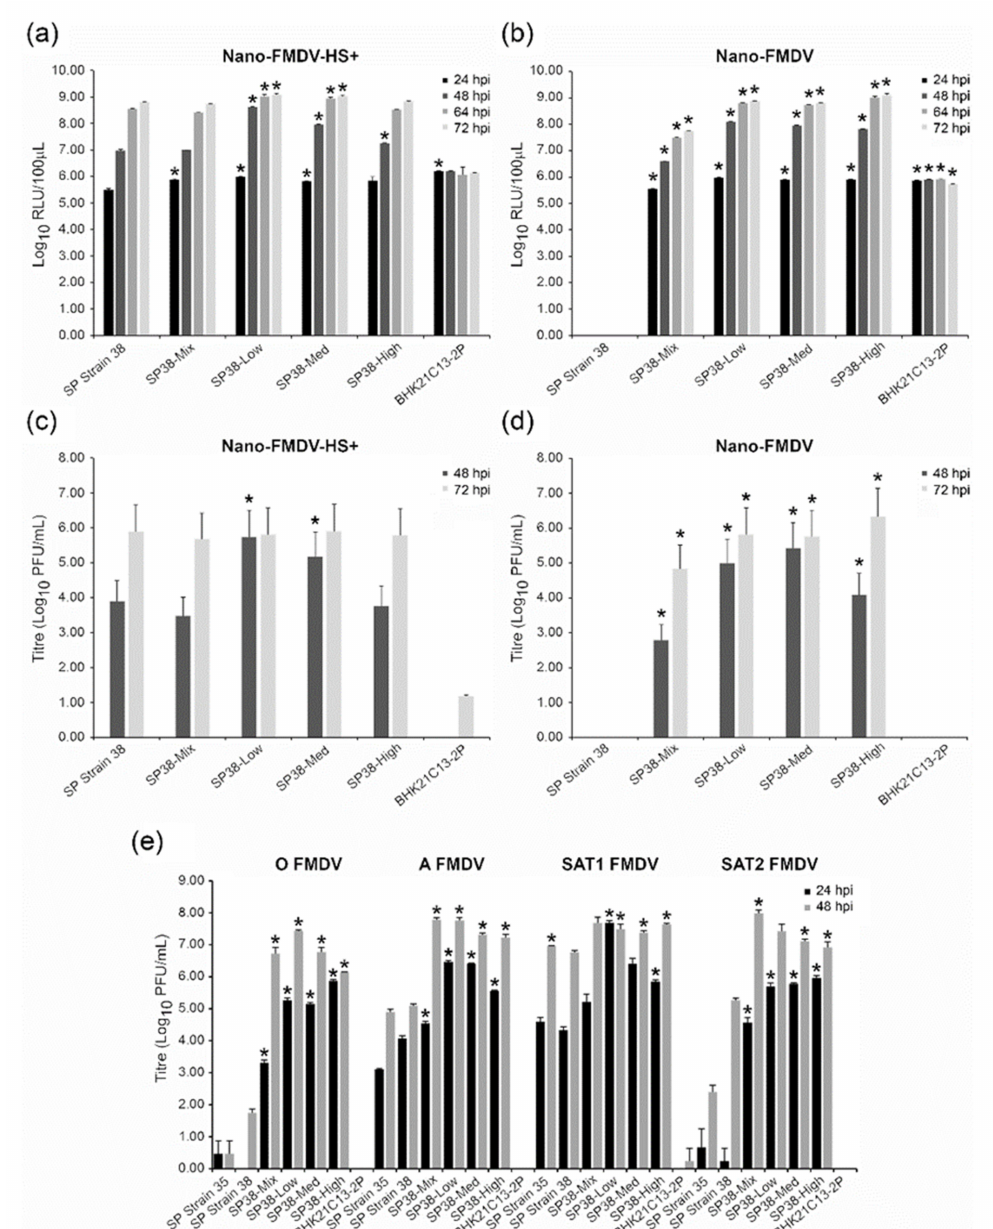
Figure 3. Comparison of virus yields following infection with non-cell culture-adapted FMDV. ( a , b ) Four α v β 6-expressing suspension cell types (SP38-Mix, SP38-Low, SP38-Med and SP38-High) were infected (MOI 0.001) with either cell culture-adapted Nano-FMDV-HS+ ( a ) or non-cell culture-adapted Nano-FMDV (b) and at 24, 48, 64 and 72 hpi, the respective cell culture supernatant was assayed for Nanoluciferase activity to assess virus replication. Parental SP Strain 38 and BHK21C13-2P were infected alongside for comparison. ( c , d ). To quantify the respective virus yields produced from these infections, the cell culture supernatants collected in ( a , b ) at 48 and 72 hpi were analyzed by plaque assay (( c , d ) respectively). ( e ). The same four α v β 6-expressing suspension cell types, in addition to parental SP Strain 38, BHK21C13-2P SP and SP Strain 35 were infected (MOI 0.005) with either O/ETH/29/2008, A/ETH/9/2008, SAT1/KEN/80/2010 or SAT2/ETH/65/2009. At 24 and 48 hpi, cell culture supernatants were collected and analyzed by plaque assay to determine the respective virus yields. These data are representative of two separate experiments performed in triplicate. Student’s T-test with unequal variance was used to compare respective virus yields between each cell type and SP Strain 38; * p <